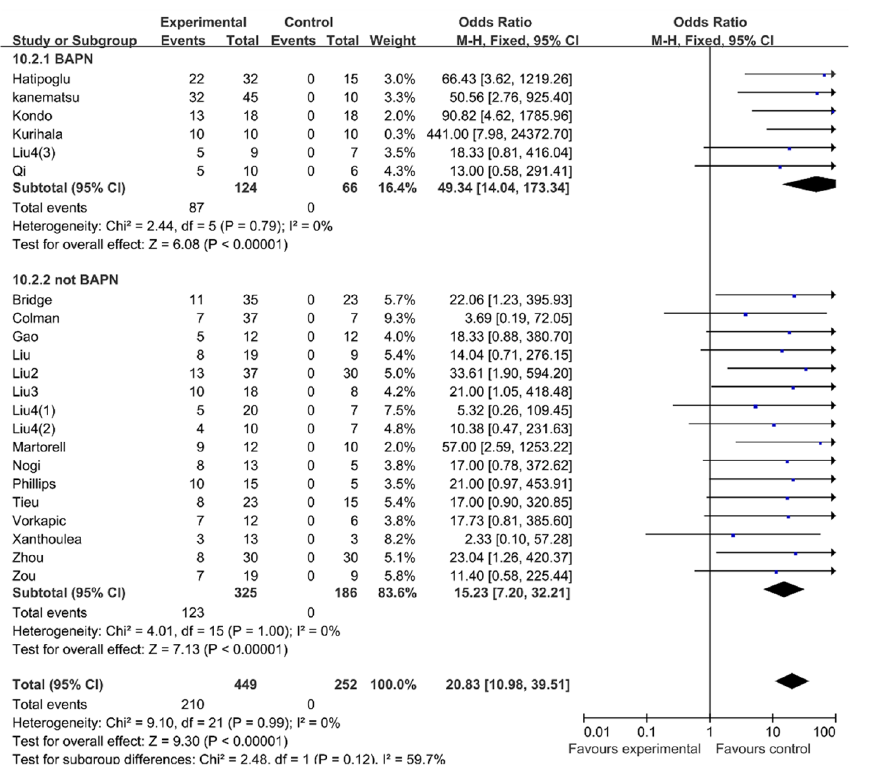
Table 3. BAPN can increase the success rate of AD model in